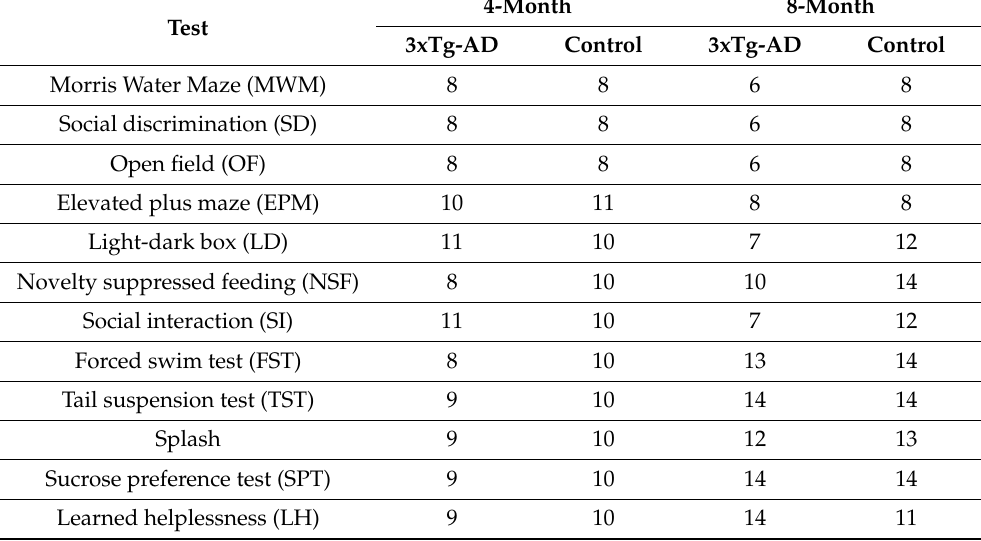
Table 2. Tests and sample